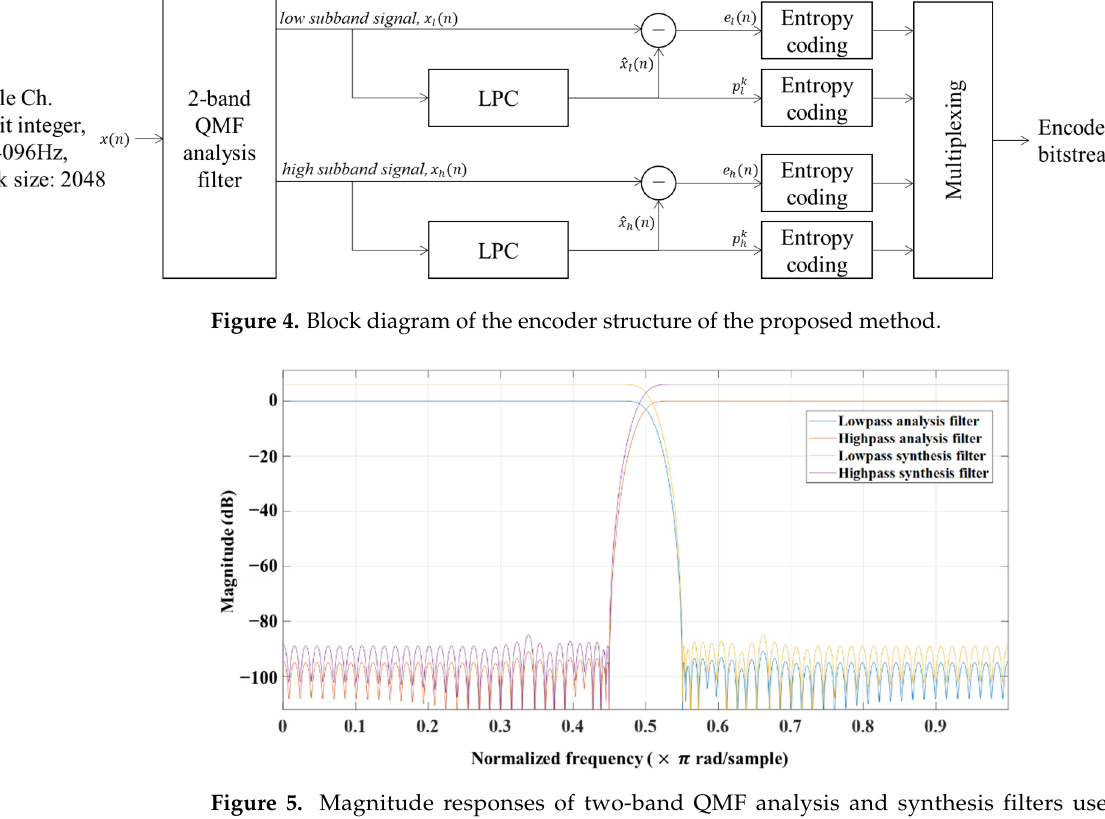
Figure 5. Magnitude responses of two-band QMF analysis and synthesis filters used in the proposed method.